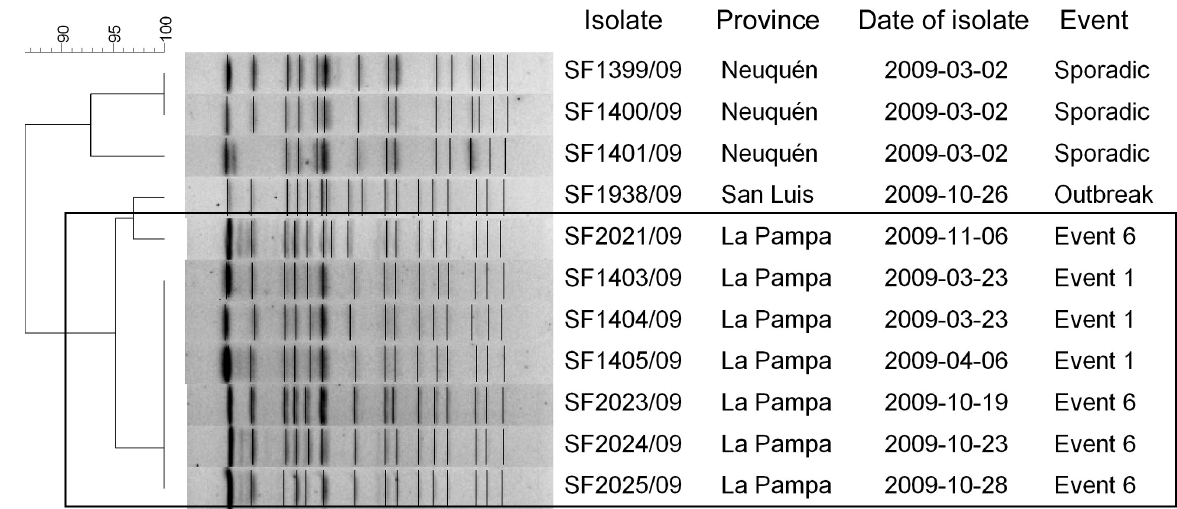
Figure 2. Dendrogram showing the genetic relatedness of isolates of S.flexneri 2 included in Event 1 and 6. Isolates recovered in Santa Rosa, La Pampa (Event 1 and 6), and selected isolates for comparison, including one from an outbreak in San Luis and three from sporadic cases in